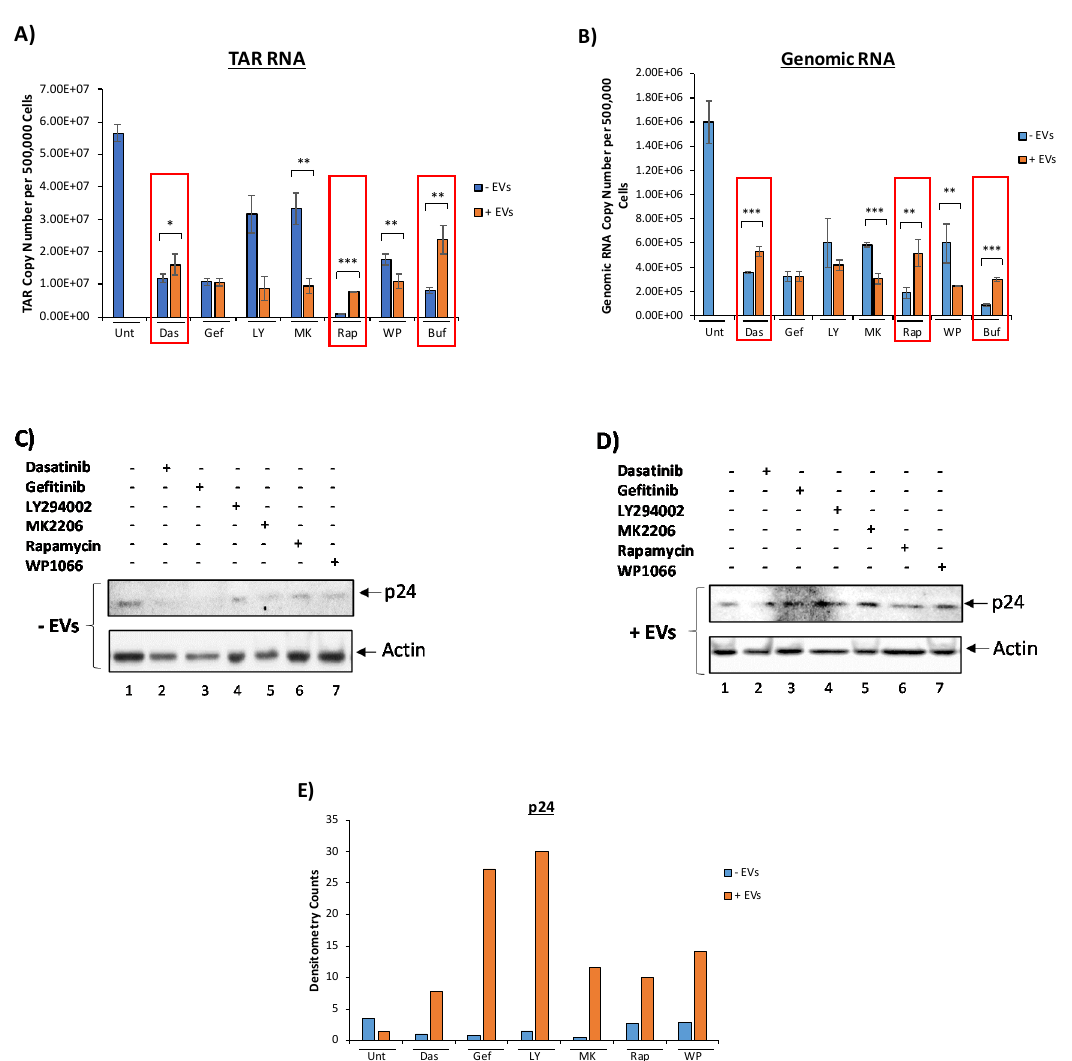
Figure 3. Effect of EVs on the activation of HIV-1 in the presence of various kinase inhibitors. CEM EVs were isolated by ultracentrifugation. Here, 5 × 10 5 U1 cells were plated and treated with 5 µM dasatinib, 10 µM gefitinib, 10 µM LY294002, 1 µM MK2206, 150 nM rapamycin, or 1 µM WP1066 and allowed to incubate for 48 h. A second drug treatment was then performed. This was followed by a 2-hour incubation and a CEM EV treatment. A second EV treatment was performed after a 24-hour incubation period. The total ratio of cells to EVs was 1:10,000. Cells were then allowed to incubate for 24 h prior to harvest. Cell supernatant was collected and rotated overnight at 4 °C with NT86. Total RNA was isolated and subjected to RT-qPCR for HIV-1 TAR RNA ( A ) and genomic RNA ( B ). Red boxes indicate increased HIV-1 TAR and genomic RNA levels in EV-treated cells in the presence of dasatinib, rapamycin, and bufalin. ( C , D ) NT86-treated samples were Western blotted for HIV-1 Gag p24. U1 WCE was used as a positive control. Actin was used as a loading control. ( E ) Densitometry counts normalized to actin are shown for HIV-1 Gag p24. For all figures, EV untreated samples were used as negative controls. Student’s t-test compared untreated cells with cells treated with drugs. *, p < 0.05; **, p < 0.01; ***, p < 0.001. Error bars, S.D.